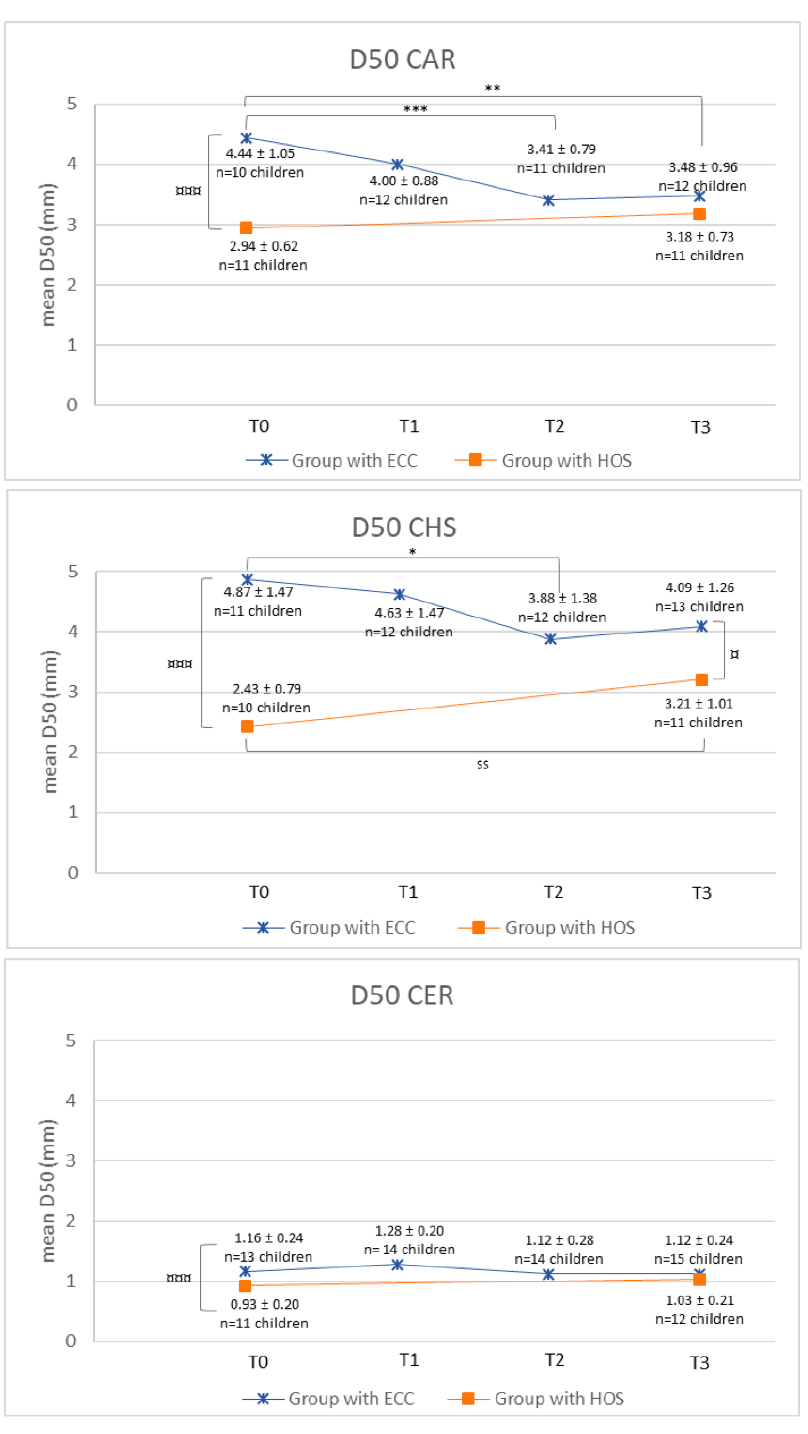
Figure 3. Evolution of mean D50 values at swallowing for the three foods throughout the study period in both groups of